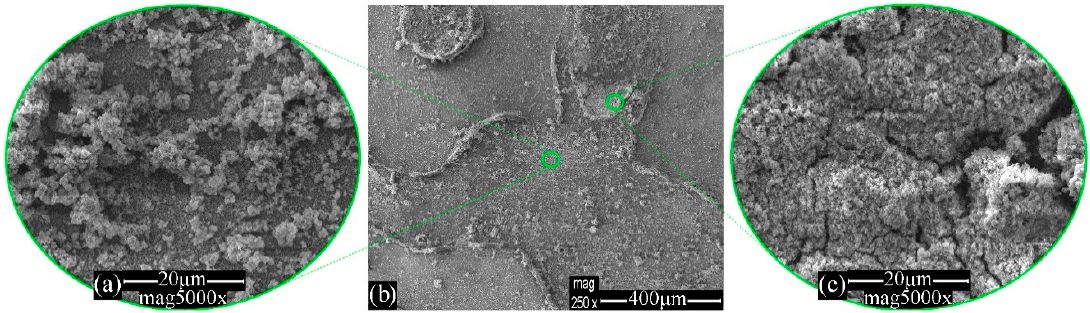
Figure 9. SEM images of mild steel immersed in 3.5 wt % NaCl for 96 h in the presence of MBT.